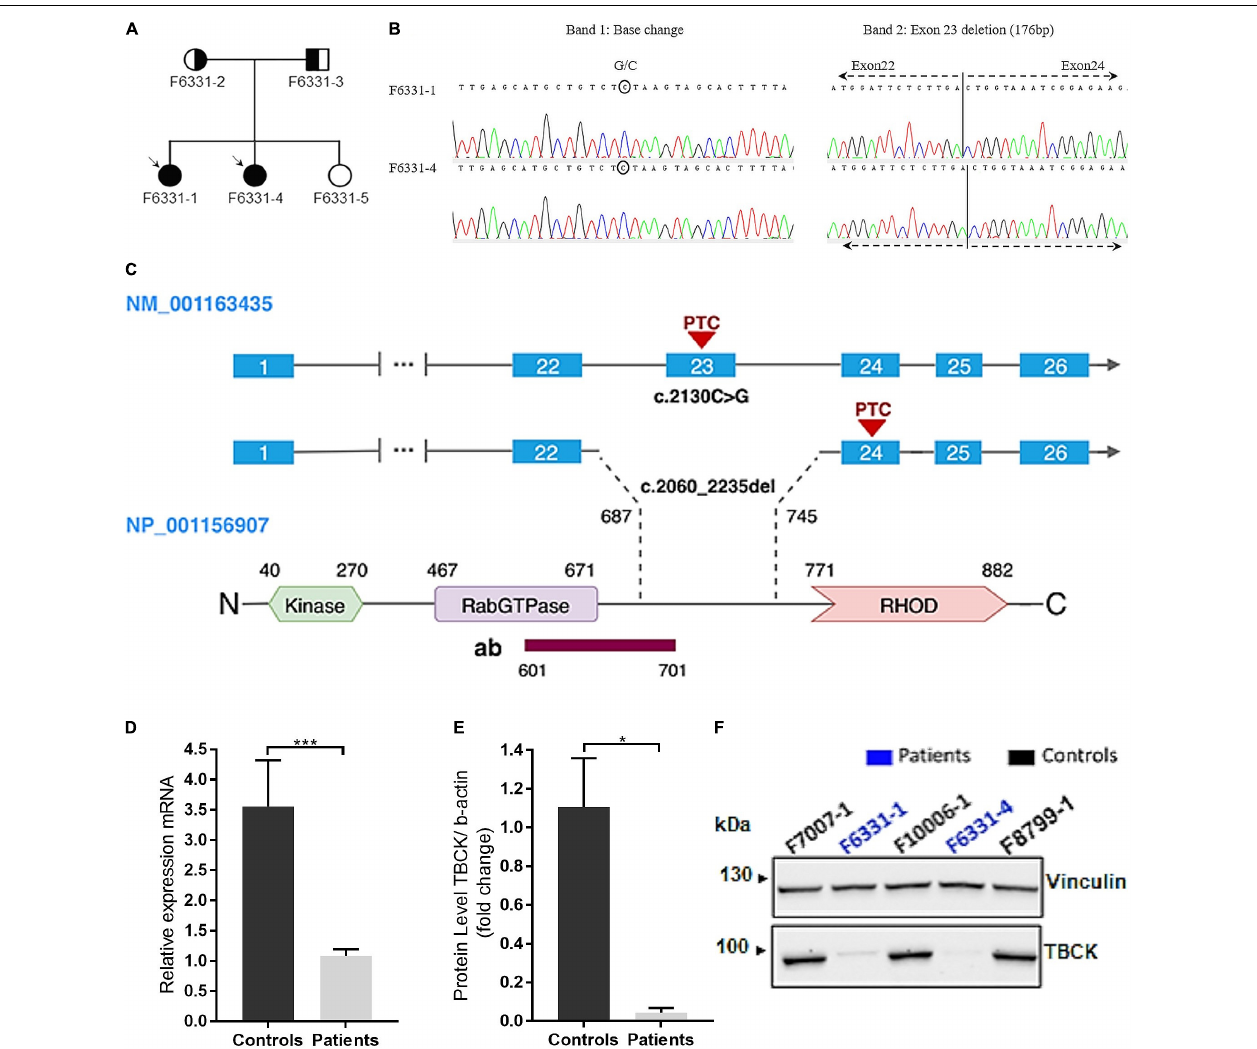
FIGURE 1 | IHPRF3 patients harboring biallelic pathogenic variants in TBCK and relative quantification of mRNA and protein expression levels in iNPC. (A) Pedigree of family F6331. Circle—female; square—male; symbol-filled—affected patients; symbol empty—not affected sister; circle half-filled—harbors the heterozygous microdeletion; square half-filled—harbors the heterozygous stopgain variant. (B) Chromatograms of the cDNA sequence show that both alleles are expressed: in the left image, a base change in Band 1 (expected base G changed to a C in reverse strand) represents the stopgain variant; and in the right image, the juxtaposition of exons 22 and 24 (excision of exon 23) in Band 2 representing the allele with the microdeletion. Bands 1 and 2 represent cDNA PCR products for TBCK in agarose gel ( Supplementary Figure 2A ). (C) Schematic representation of TBCK transcript and protein. The illustration shows the two mutant isoforms identified in the patients and the predicted positions on the protein. The antibody target region is also represented. The pathogenic variants create a putative premature termination codon (PTC) in exons 23 and 24, located within the C-terminal region of the protein, upstream of the RHOD domain. (D) TBCK mRNA expression (data from TBCK-mRNA-3 primer pair) shows reduced transcript levels in patients, compared with controls. Each biological sample had three technical replicates, and each individual was considered a biological replicate. (E,F) Western blot (WB) shows low levels of TBCK protein in iNPC of patients, compared with iNPC of controls, which are compatible with an autosomal recessive inheritance condition. * p -value < 0.05, *** p -value < 0.001, and n.s.—not significant. Data on graphs are shown as mean ± SD of technical replicates and biological samples. Patients: F6331-1 and F6331-4 ( N = 2); controls: F7007-1, F8799-1, and F10006-1 ( N = 4).